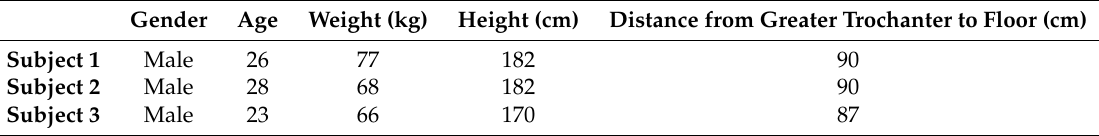
Table 1. Characteristics of the